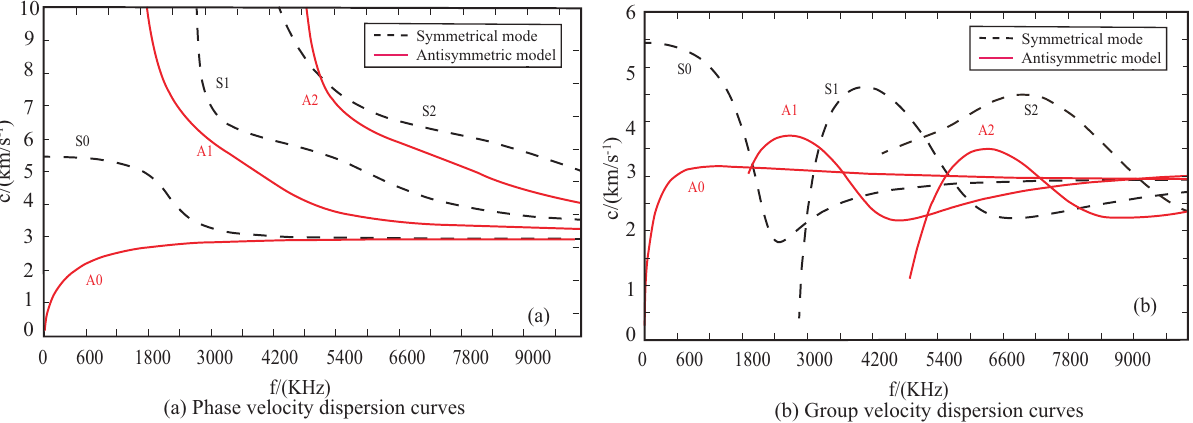
Figure 2. Dispersion curve of aluminum alloy plate.